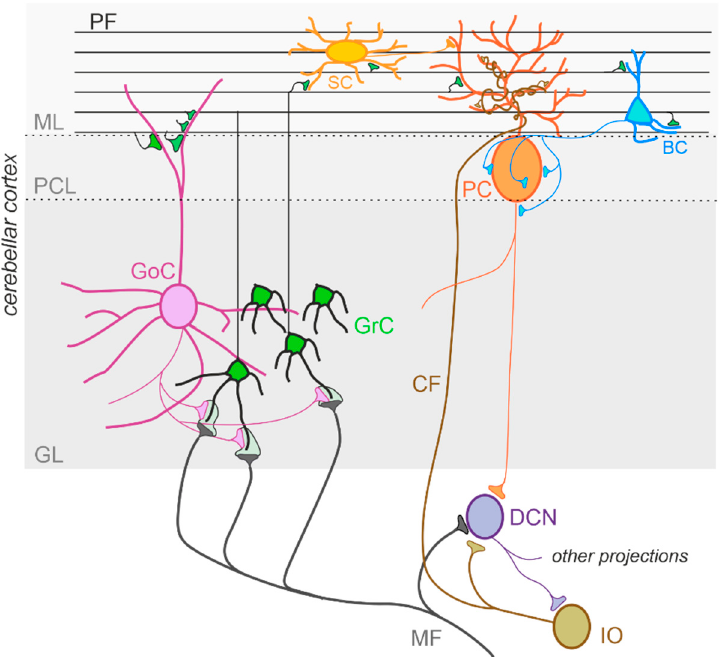
Figure 2. The cerebellar circuit. Schematic representation of the main components of the cerebellar circuit. The inputs are provided by mossy fibers (MF) and climbing fibers (CF), these latter originat- ing in the inferior olive (IO). Both inputs send collaterals to the deep cerebellar nuclei (DCN) before entering the cerebellar cortex. Granule cells (GrC) and Golgi cells (GoC) are the main neuronal types present in the granular layer (GL) of the cerebellar cortex. GrC axons reach the molecular layer (ML) where they bifurcate originating the parallel fibers (PF). The inhibitory interneurons in the ML are stellate cells (SC) and basket cells (BC), which inhibit Purkinje cells (PC) in the Purkinje cell layer (PCL). The PC provides the output of the cerebellar cortex, inhibiting DCN neurons, which in turn provide the main output of the cerebellar circuit. Notice that DCN project to the IO, generating a loop mediated by the CF. 3.2. Cerebellar Connectivity to Social Brain Areas Experiments using task-based fMRI and positron emission tomography (PET) re- vealed that separate regions of the cerebellum are associated with distinct cerebral areas through polysynaptic circuits, forming a functional topography [119–122]. The sensorimo- tor cerebellum is represented in the anterior lobe (lobules I-V) and lobule VIII, while the cognitive cerebellum comprises the posterior lobe (lobules VI and VII), including hemi- spheric extensions (CrusI/CrusII) [122]. Finally, the posterior vermis and hemispheres rep- resent the limbic cerebellum [122–124]. The DCN send direct projections to the ven- trolateral (VL) and the intralaminar thalamic nuclei, particularly the dorsomedial (MD) nucleus [125]. The VL nucleus, classically known as an integrative center for sensorimotor transformations, targets the primary motor cortex (M1) [42,126,127], whereas the MD nu- cleus, like other intralaminar nuclei, has widespread cortical projections including the mPFC (Figure 3A) and the superior temporal sulcus [128–132]. Past anatomical studies demonstrated that the cerebellum is interconnected with parts of the limbic system, in- cluding the hippocampus, amygdala, and cingulate cortex (Figure 3B) [133,134]. Recently, Bohne and colleagues [135] reported an elegant tracing study identifying a new cerebellar- hippocampal connection via the VL thalamic nucleus in mice. In support of this finding, unilateral removal of the cerebellar hemispheres [136] or PC signaling deficits [137] deter- mined an impairment in hippocampal-based behavioral tasks as goal-directed navigation tests. Furthermore, monosynaptic projections originate in the hippocampus to primarily target the PFC in rodents and primates [138,139]. Several shreds of evidence obtained us- ing different methodologies show that the cerebellum and amygdala are connected [140].